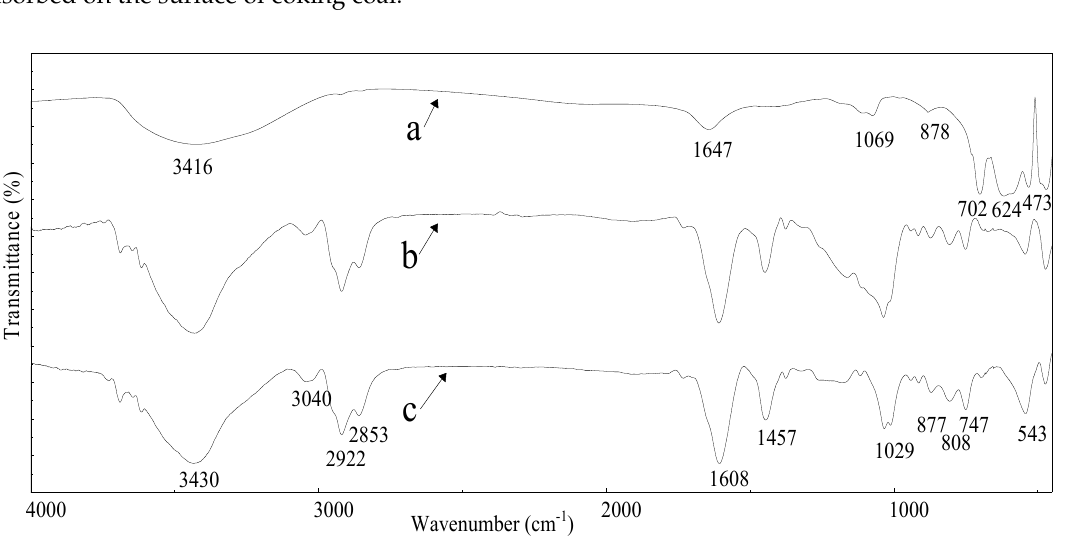
Na 1s a Figure 10 . The X-ray photoelectron spectroscopy and partial enlargement of coking coal after adsorption (a) and coking coal before adsorption(b). To further investigate the adsorption mechanism, XPS data analysis was performed with the XPSPEAK4.1 program. The high resolution spectrum of C1s was divided into four characteristic peaks. They are respectively 284.8 eV (C-C/C-H), 289.59 eV (C=O), 286.3 eV (C-OH/C-O-C) and 285.74